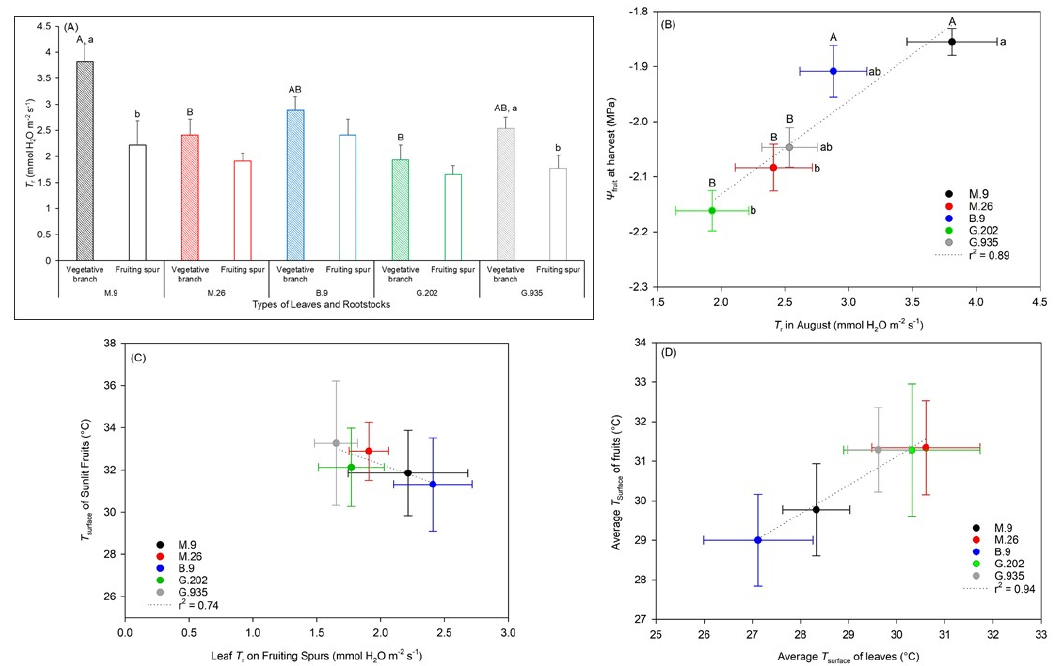
Figure 8. Leaf transpiration and its relationship to the tissue surface temperature of Ambrosia TM apple on five rootstocks at the onset of heat stress in the second-year planting. ( A ) Transpirational rate T r of leaves on vegetative branches and on fruiting spurs; ( B ) relationship between leaf T r and water potential of fruit hypanthium Ψ fruit ; ( C ) relationship between leaf T r and surface temperature T surface of sunlit fruits on fruiting spurs; and ( D ) relationship between average leaf T surface and average fruit T surface . In ( A ), different uppercase letters stand for significant differences amongst rootstocks; different lowercase letters stand for significant differences between vegetative branches and fruiting spurs in each rootstock; in ( B ), different uppercase and lowercase letters stand for significant differences amongst rootstocks in Ψ fruit and in leaf T r , respectively ( P ≤ 0.05, ANOVA, Fisher LSD pairwise comparisons). The absence of letters stands for no significant